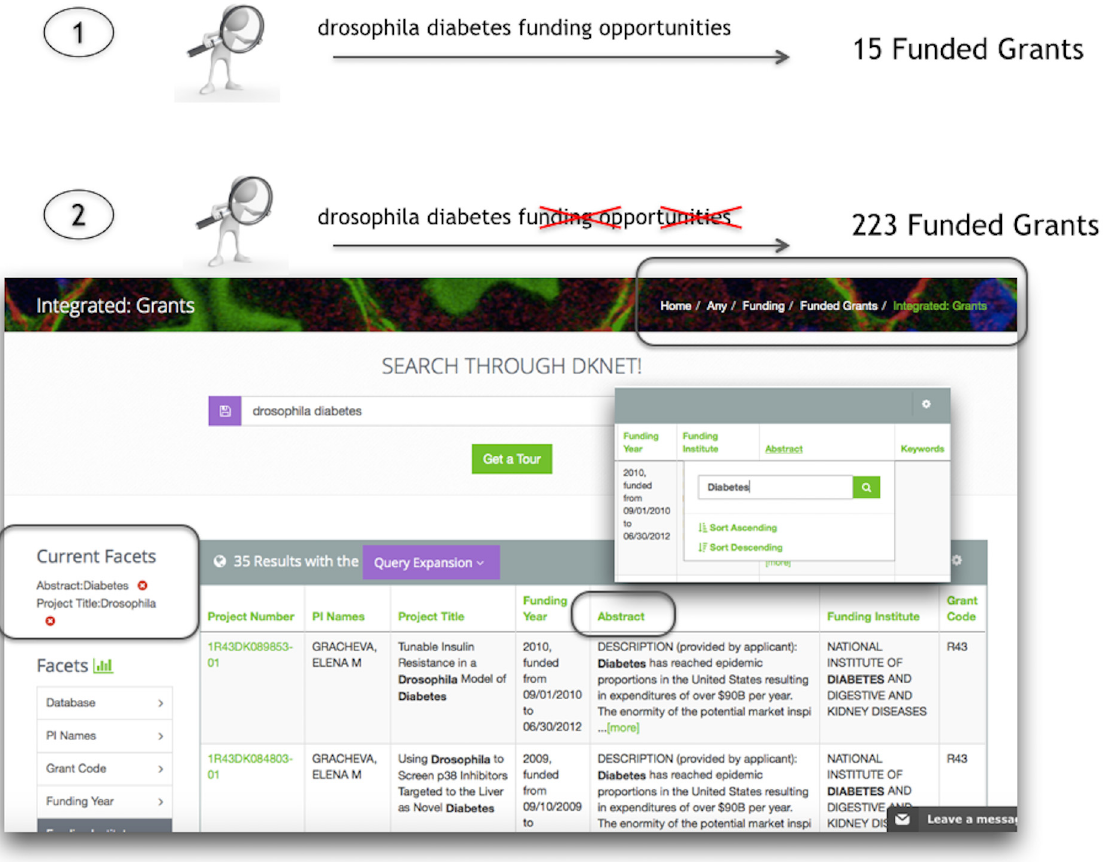
Fig 7. Workflow to search for funding opportunities related to drosophila and diabetes. In the first search using the terms “ drosophila diabetes funding opportunities ” a limited number of results are returned. Since dkNET includes a funding category and an opportunities subcategory, theses terms can be removed as search terms, therefore expanding the search and returns 223 (6/2015) records. This expanded set of results can then be further filtered in the table